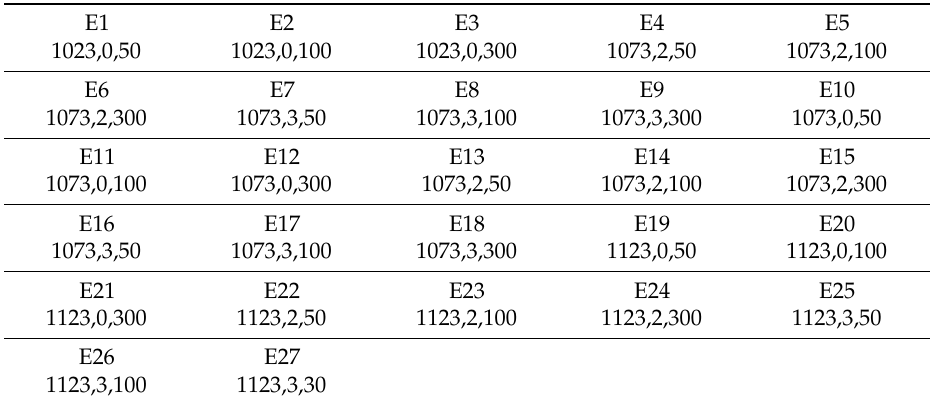
Table 2. Design of total experiments ( E i,j,k ). i —temperature (K); j —initial Mg concentration (wt-%); k —agitation speed (rpm).